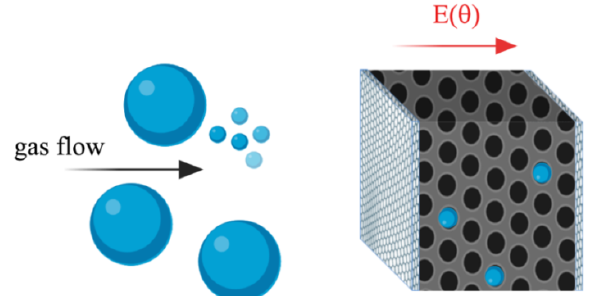
Figure 1. Proof of concept of the zeolite-based gas sensor. A nanoporous layer acts as a molecules- sensitive dielectric, allowing a capacitive detection of the analyte, which results in an electrical signal correlated to the gas species adsorbed. The metal layers, together with the nanoporous dielectric, form a parallel plate capacitor whose electrodes are permeable to the gas stream, in order to allow a full diffusion of the molecules inside the zeolite. E(θ) represents the electric field between the two large parallel plates which is expected to be function of θ, defined as the number of adsorbed molecules compared to the total number of adsorption sites.